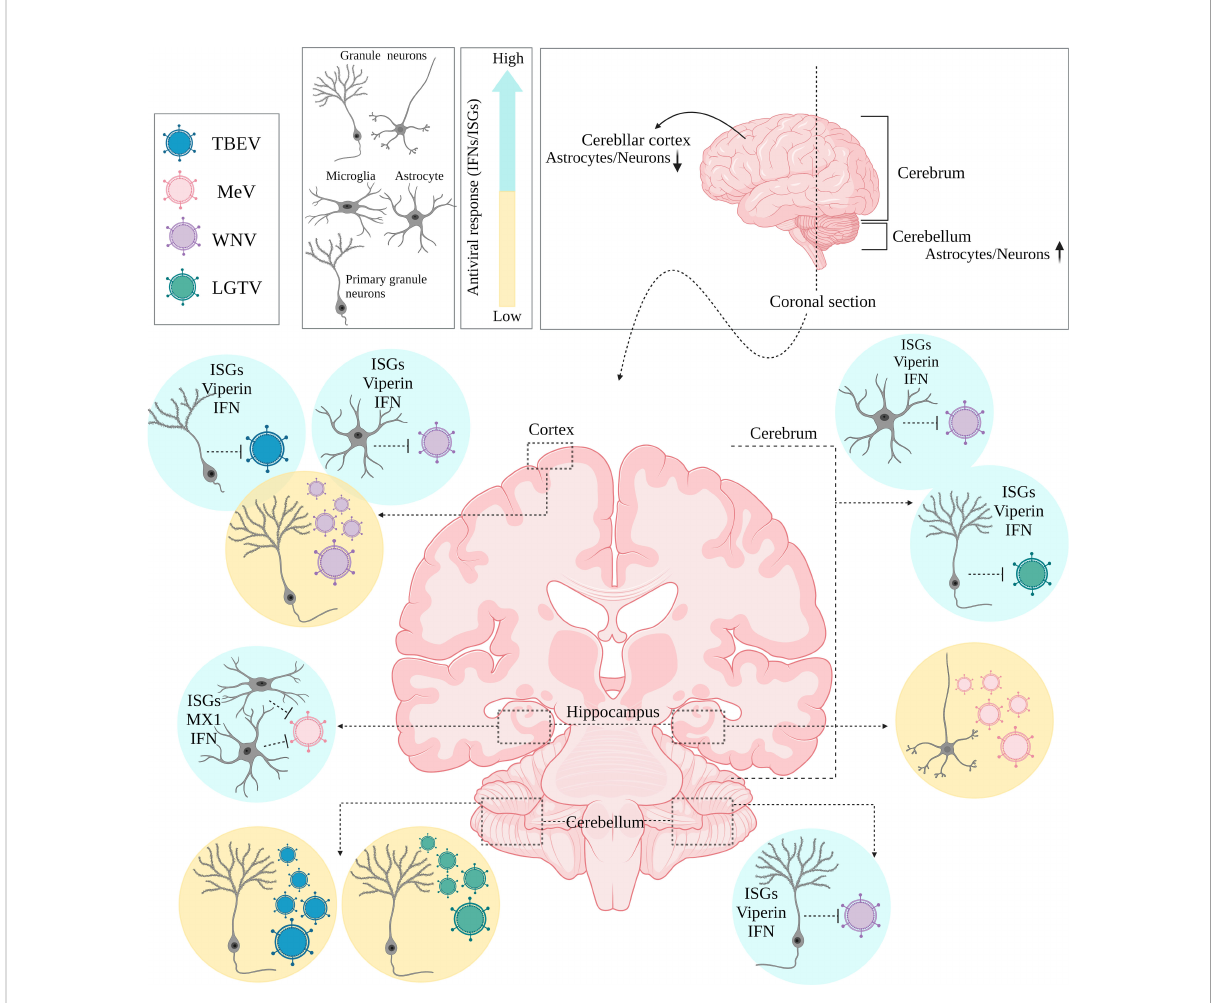
FIGURE 3 Regional diversity of innate immune responses within the brain. Coronally section of the human brain. Differential permissiveness of various cell types (Granule cell neurons, astrocytes and Microglia) situated in distinct anatomical locations (cortex, cerebrum and cerebellum) within the brain to several viruses; highlighting potent contribution of type I IFN mediated signaling pathways and over expression of relative